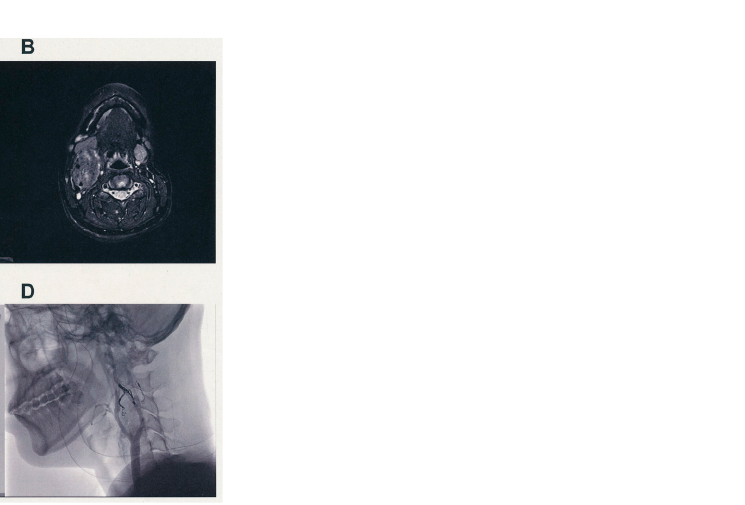
Figure 1. Typical diagnostic images and results of pre-operative embolization followed by surgery (Case 19). ( A ) Anterior coronal view ( B ) Axial view of T2-weighed magnetic resonance (MR) image of the carotid body tumor (CBT). The tumor is located at the right carotid bifurcation, with an estimated size of 48 × 46 × 32 mm on the image. The tumor was categorized as Shamblin type III, as it is found enclosing the right carotid bifurcation, ECA, and ICA. ( C ) Lateral view of the digital subtraction angiography (DSA) image before embolization of the feeding arteries. ( D ) The same view as in ( C ) after embolization. The feeding arteries from the ascending pharyngeal, occipital, superior thyroid, facial, and inferior thyroid arteries were selectively injected with gelatin sponge or coil embolization was performed (see Materials and Methods). Almost all blood supplies were obstructed by embolization.